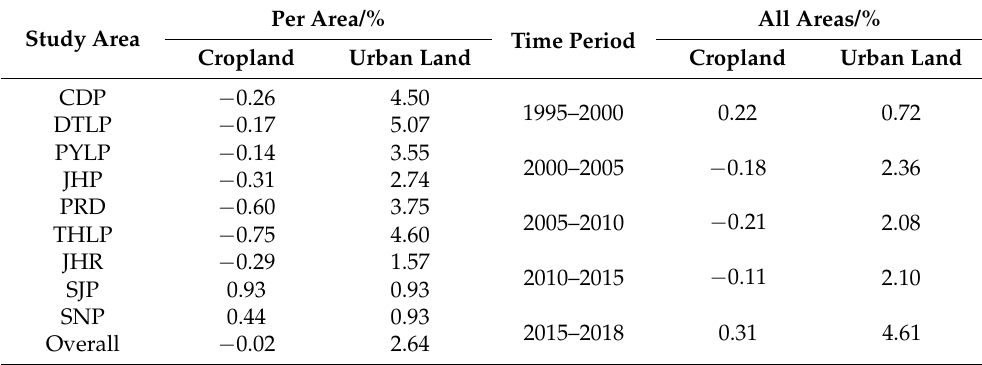
Figure 2. ( a ) Area of land-use types at the entire level; ( b ) Area of cropland and urban land, 1995–2018. Table 2. Land use dynamic degree at the individual